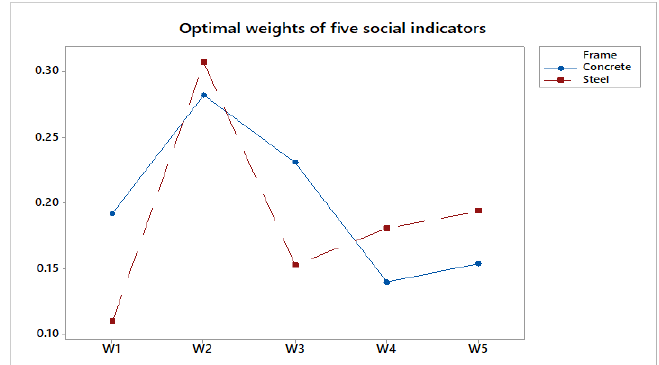
Figure 8. Final results of social sustainability assessment for the two frames (w 1 : Health and